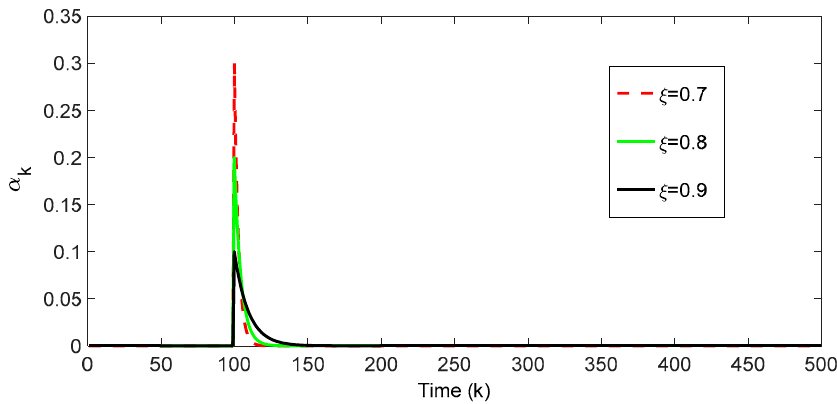
 . Figure 1. The distribution of weights of innovations under different ξ